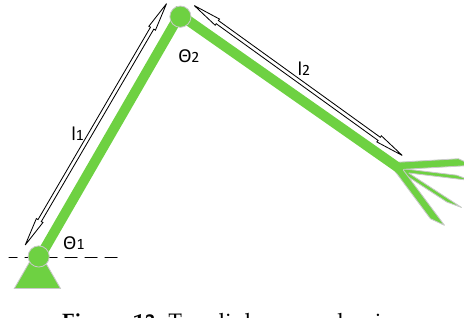
Figure 13. Two-linkage mechanism.